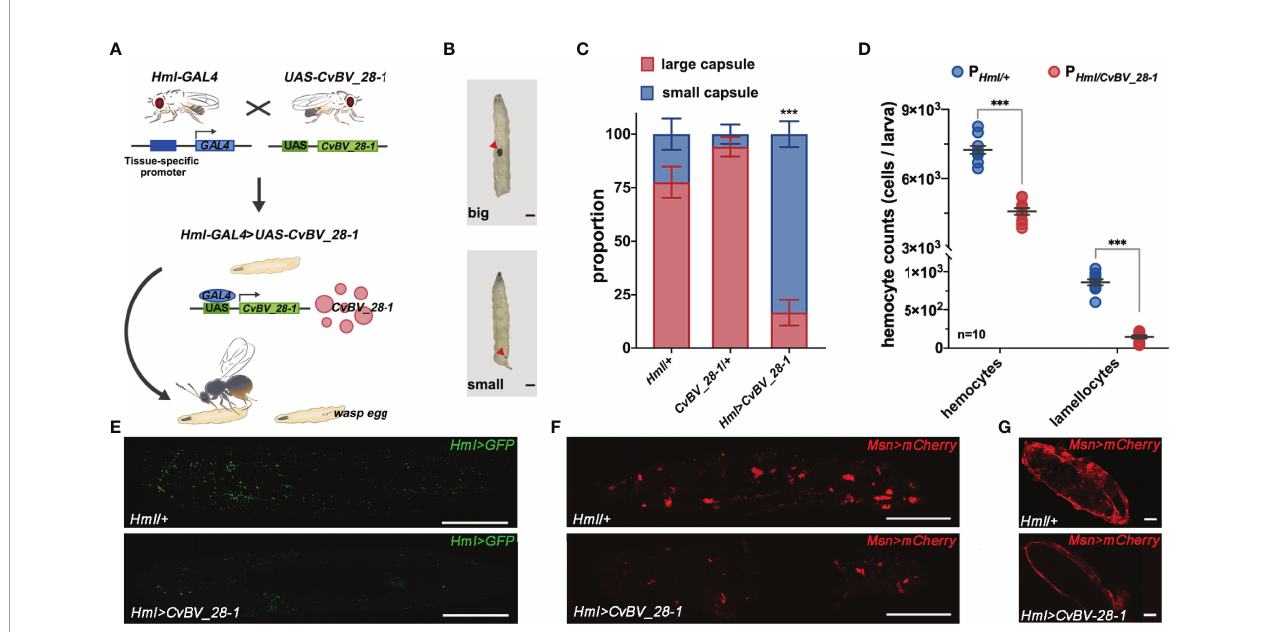
FIGURE 4 | CvBV_28-1 suppresses encapsulation by reducing host hemocytes. (A) A working model of ectopically expressed of CvBV_28-1 in Drosophila hemocytes using the GAL4/UAS system and conducting L. boulardi parasitization in transgenic fl ies. (B) Images of the encapsulated phenotypes of L. boulardi eggs in Drosophila larvae 48 h post-parasitization. Red arrowheads represent melanotic encapsulated wasp eggs. Melanotic encapsulation covered more than 50% of the wasp egg, de fi ned as a large capsule, and less than 50% encapsulation was de fi ned as a small capsule. (C) Quanti fi cation and phenotypic classi fi cation of Drosophila